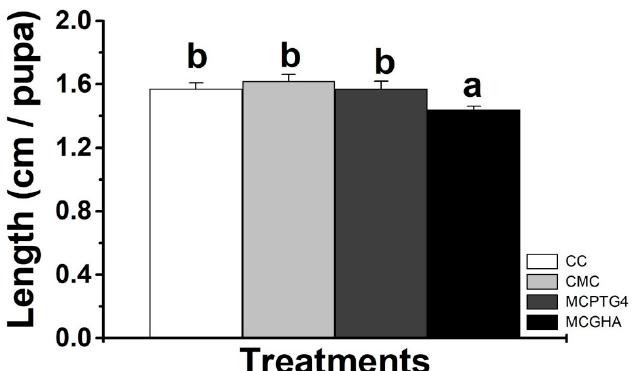
Figure 4. S. frugiperda pupal length after feeding on plants treated with the specified treatments. CC: Negative control, CMC: Negative control with only methylcellulose, MCPTG4: B. bassiana fungal strain PTG4 with methylcellulose, MCGHA: B. bassiana fungal strain GHA with methylcellulose. Analysis done with Duncan’s post-hoc multiple range test ( α = 0.05) after one-way ANOVA. Graphical bars with the same letter indicate that there were no significant differences among them.